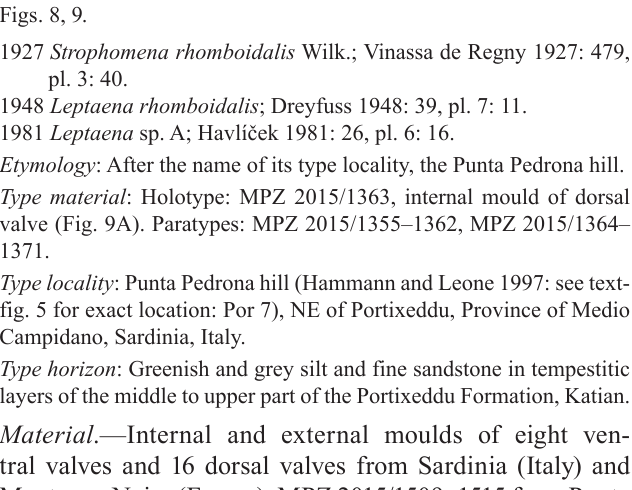
fig. 5 for exact location: Por 7), NE of Portixeddu, Province of Medio Campidano, Sardinia, Italy. Type horizon : Greenish and grey silt and fine sandstone in tempestitic layers of the middle to upper part of the Portixeddu Formation,